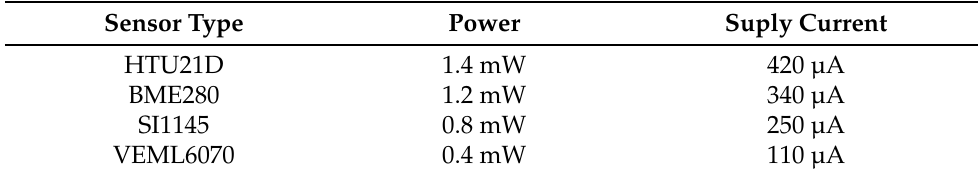
Table 15. Energy consumption of sensors selected for the use in the flying weather